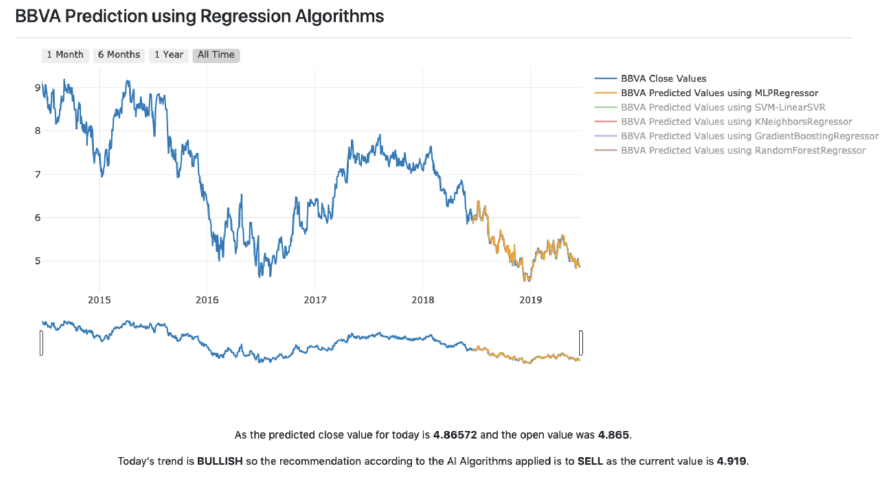
Figure 17. Prediction using regression